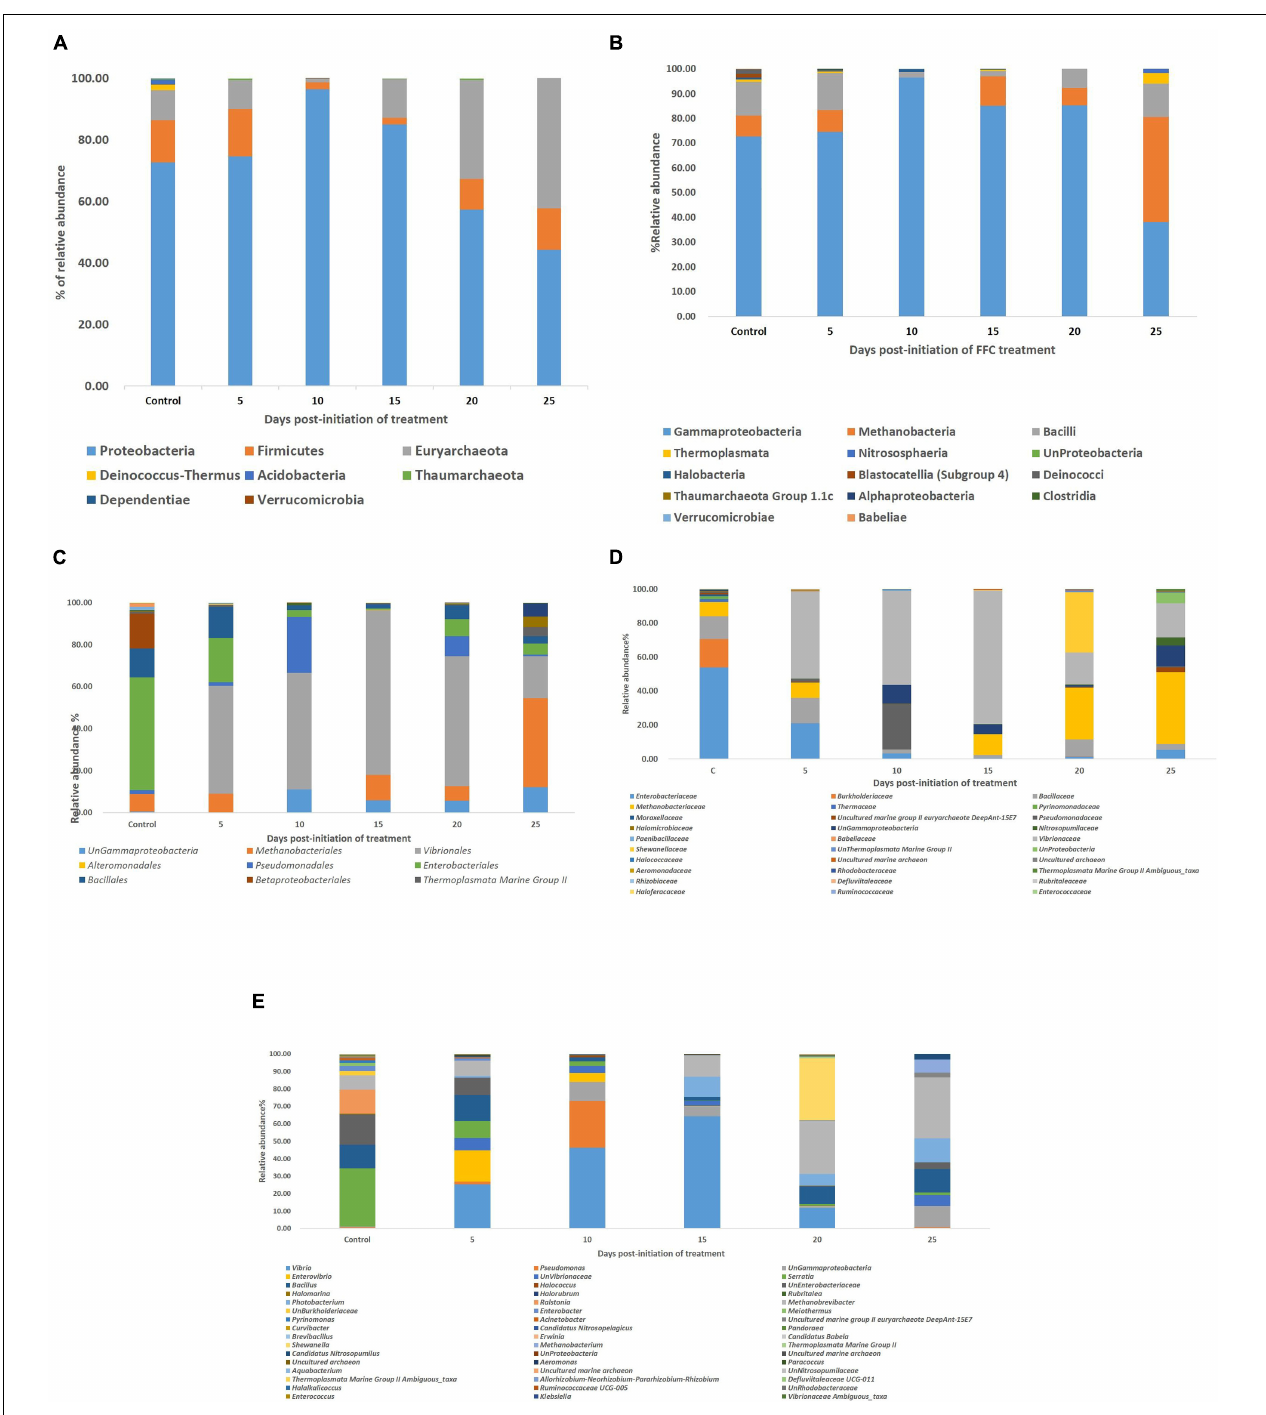
FIGURE 3 | Impact of FFC therapeutic exposure on the gut microbiome taxonomy. (A) At phylum level; (B) at class level; (C) at order level; (D) at family level; (E) at genus level. FFC, florfenicol. ( Figure 6D ). At the genus level, there were several transient trend from five days post-initiation of FFC treatment, reached changes, however, the relative abundance of Serratia sp. and the maximum level at five days post-withdrawal, and then showed a decreasing trend ( Figure 6E ). The details of the major Acinetobacter sp. remained significantly at a lower level even at 15 days post-withdrawal ( Figure 6E ). It was striking to note changes in the gut microbial taxonomy are briefly represented that the relative abundance of Vibrio sp. showed an increasing